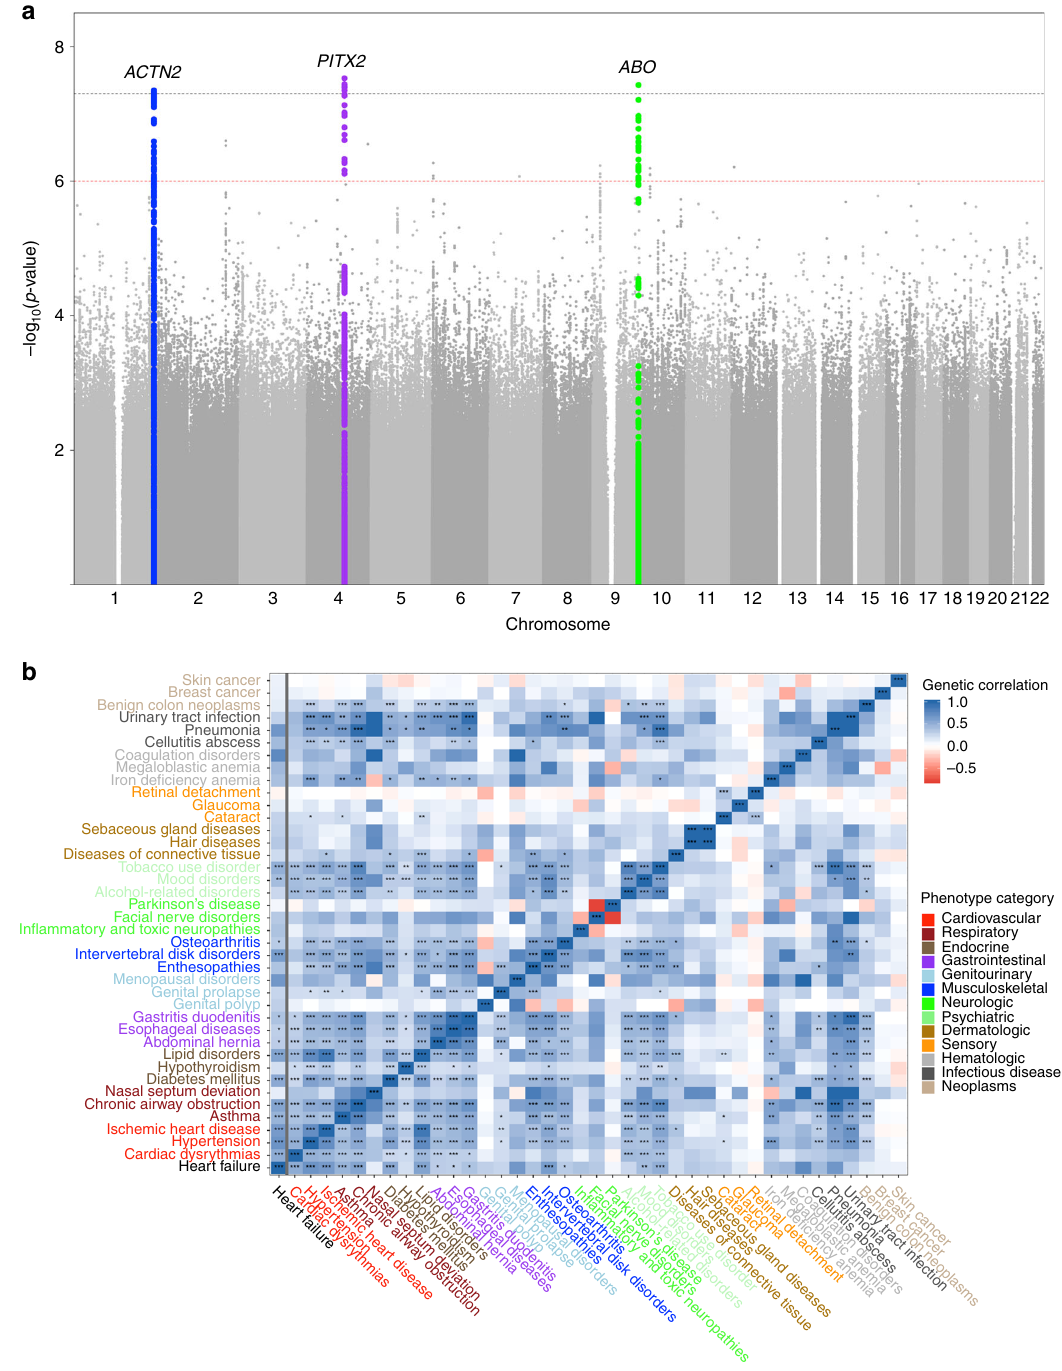
Fig. 1 Summary GWAS and genetic correlation plots. a Manhattan plot of the GWAS meta-analysis. The black dotted line denotes the genome-wide signi fi cance threshold ( p -value < 5e-8) while the red dotted line denotes the suggestive threshold ( p -value < 1e-6). N = 448,549 independent participants. b Genetic correlation values between heart failure and other complex traits. The x -axis shows the genetic correlation r -value. Traits are color coded based on the group in which they belong. Stars denote the Bonferroni adjusted z -test p -value: (*) 0.001 < p -value < 0.01, (**) 0.0001< p -value < 0.001, (***) p -value < 0.0001. N = 1,171,562 SNPs. Source data are provided as a Source Data fi